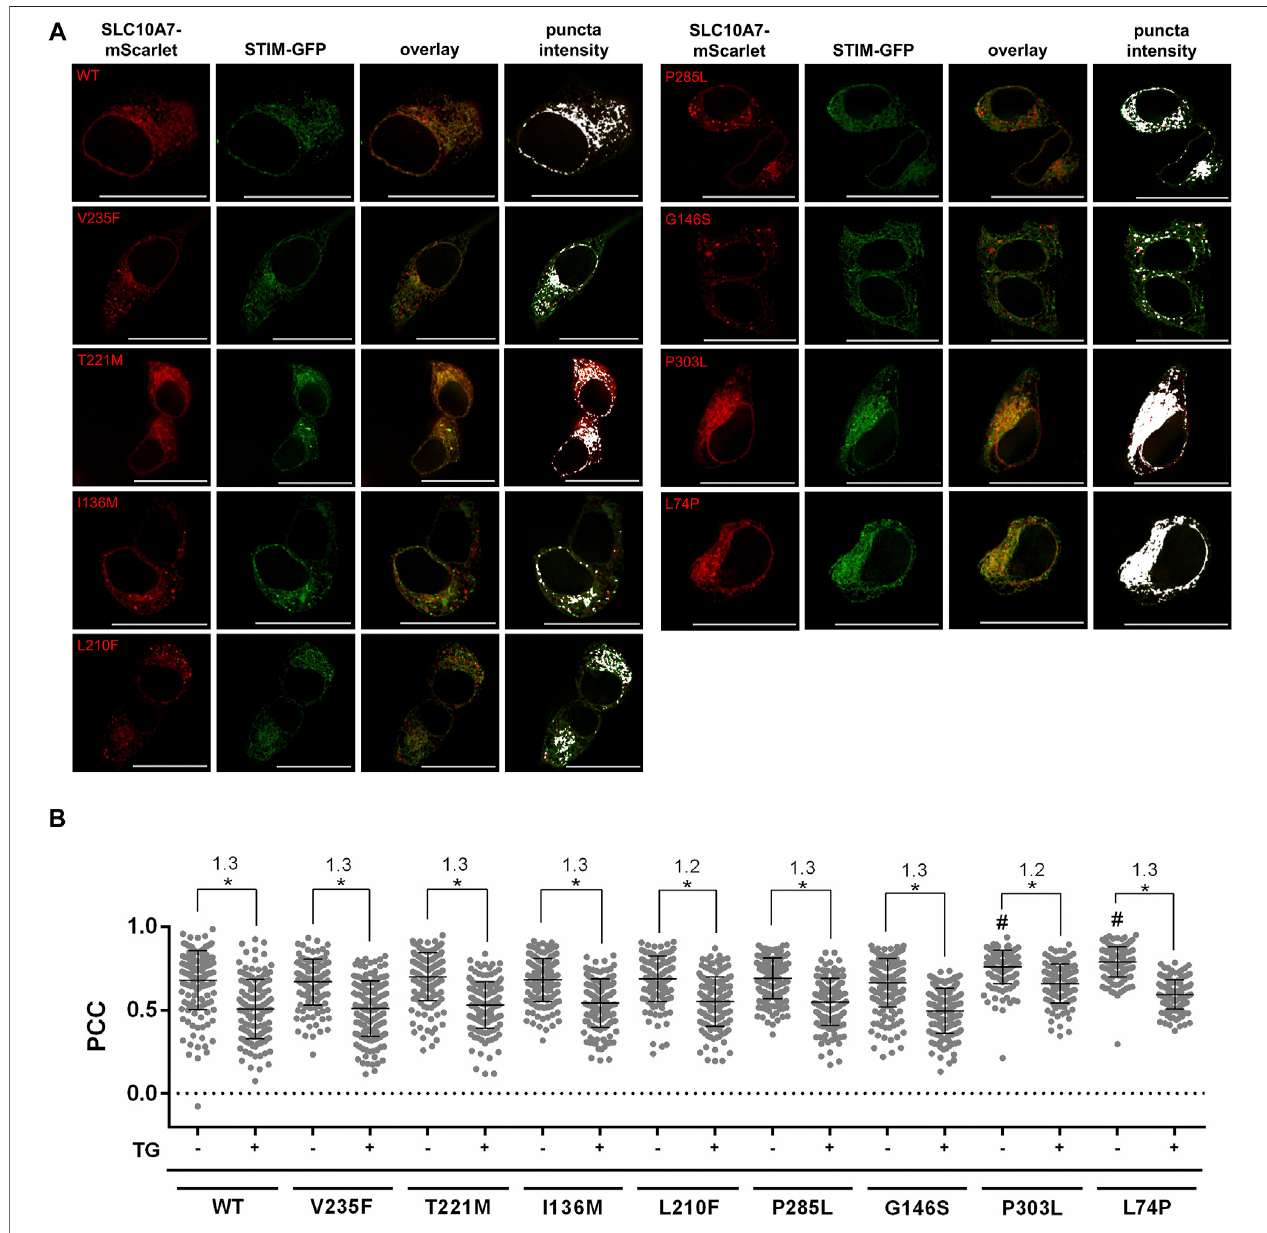
FIGURE 3 | Co-localization of STIM-GFP with SLC10A7-mScarlet wild-type (WT) and mutant (V235F, T221M, I136M, L210F, P285L, G146S, P303L, and L74P) constructs before and after treatment with thapsigargin (TG). (A) Representative fl uorescence images show GFP/mScarlet co- fl uorescence before treatment with TG. Images represent maximum projections of Z-stacks at 630 × magni fi cation after deconvolution. (B) Graphical representation of the co- fl uorescence, expressed as Pearson ’ scorrelationcoef fi cient(PCC)before( – TG)andafter(+TG)treatmentwithTG.EachdotrepresentsthePCCofasinglecell.Approximately120 – 200single cells per construct were analyzed. Ratios of the mean values of treated and untreated cells are also given. Means ± SD of three combined independent experiments ( n (cid:2) 3) of the measured PCCs are indicated by lines. * Signi fi cantly different at p < 0.05. # Signi fi cantly different from WT SLC10A7. Scale bars: 25